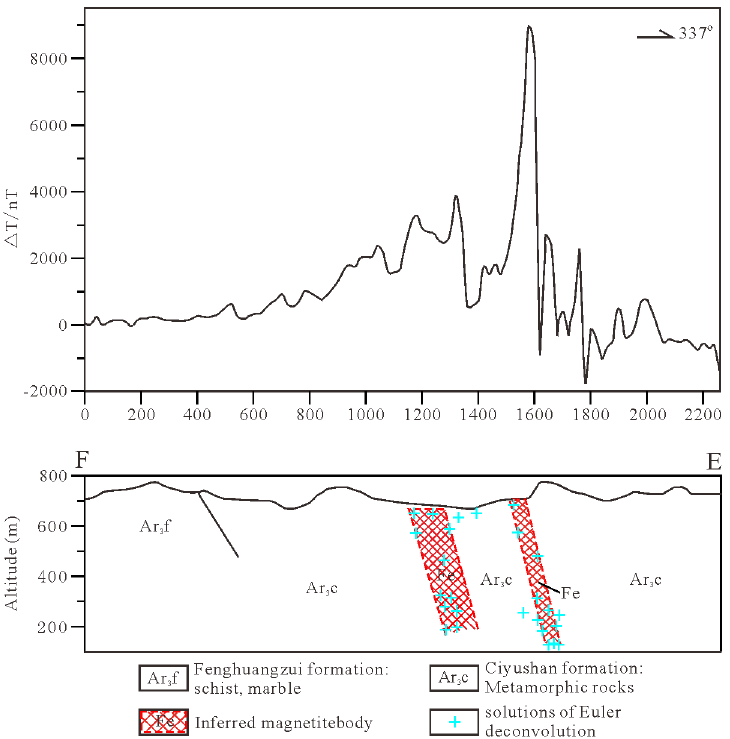
Figure 13. Magnetic data Δ T profile of the ground survey (line NO. 227).